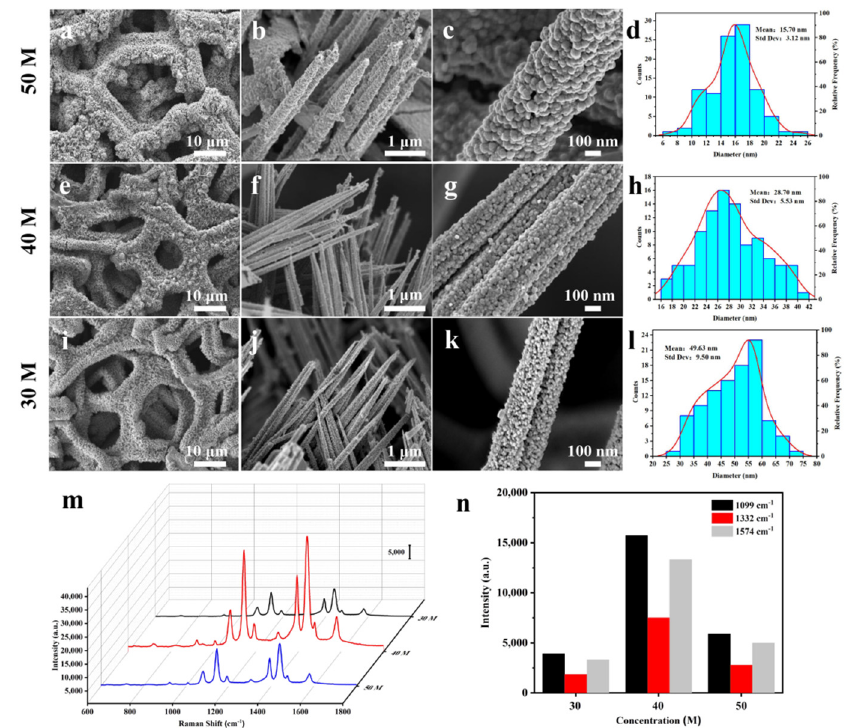
Figure 3. ( a ) SEM images of Cu@Co 3 O 4 @Ag-H prepared from different concentrations of silver ammonia solution ( a – c ) 50 M, ( e – g ) 40 M, ( i – k ) 30 M. ( d , h , l ) Corresponding Ag NPs size distribution. ( m ) Raman spectra of 10 -3 M 4-NBT ethanol solution on three different substrates and ( n ) corresponding intensity distribution of the 1099 cm -1 , 1332 cm -1 and 1574 cm -1 peaks.